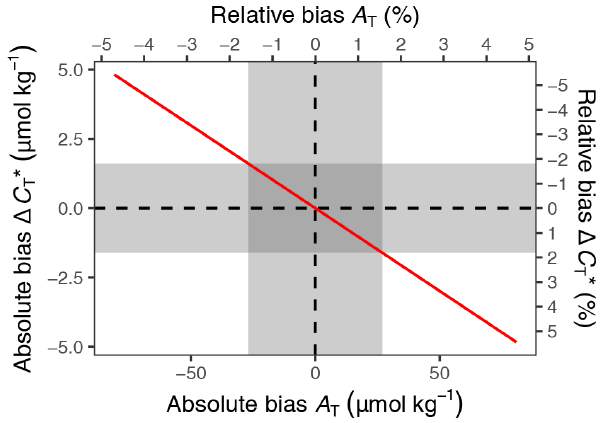
Figure C1. Bias of changes in C ∗ as a function of the bias in mean T A T used for calculation (see Fig. B1). Results correspond to the p CO 2 and temperature conditions observed in this study and are expressed in absolute and relative units. Grey areas highlight ± 1 standard deviation around the mean A T